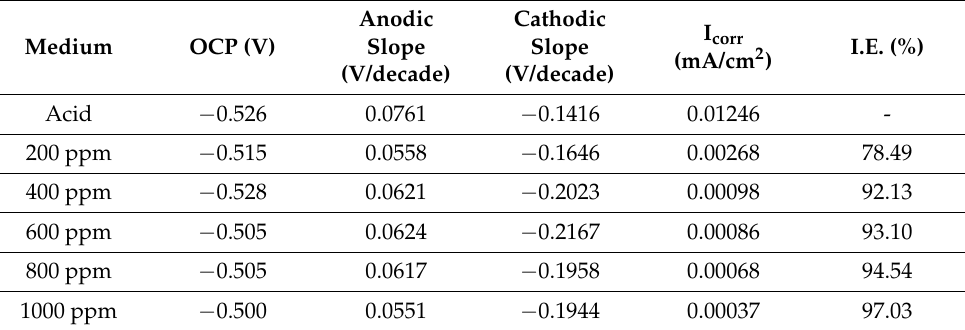
Table 4. Table showing the anodic slope, cathodic slope, and inhibition efficiency for the 3 h immersed